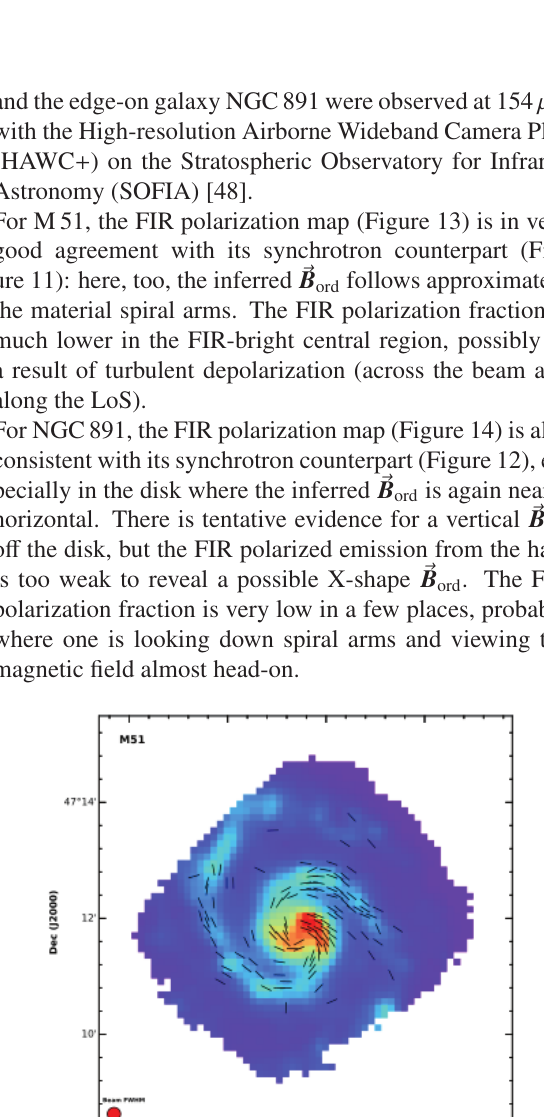
Figure 13. Total intensity map of the λ 154 μ m FIR contin- uum emission from the face-on spiral galaxy M51 observed with SOFIA / HAWC + . The small bars show the polarization half- vectors rotated by 90 ◦ to trace the orientation of